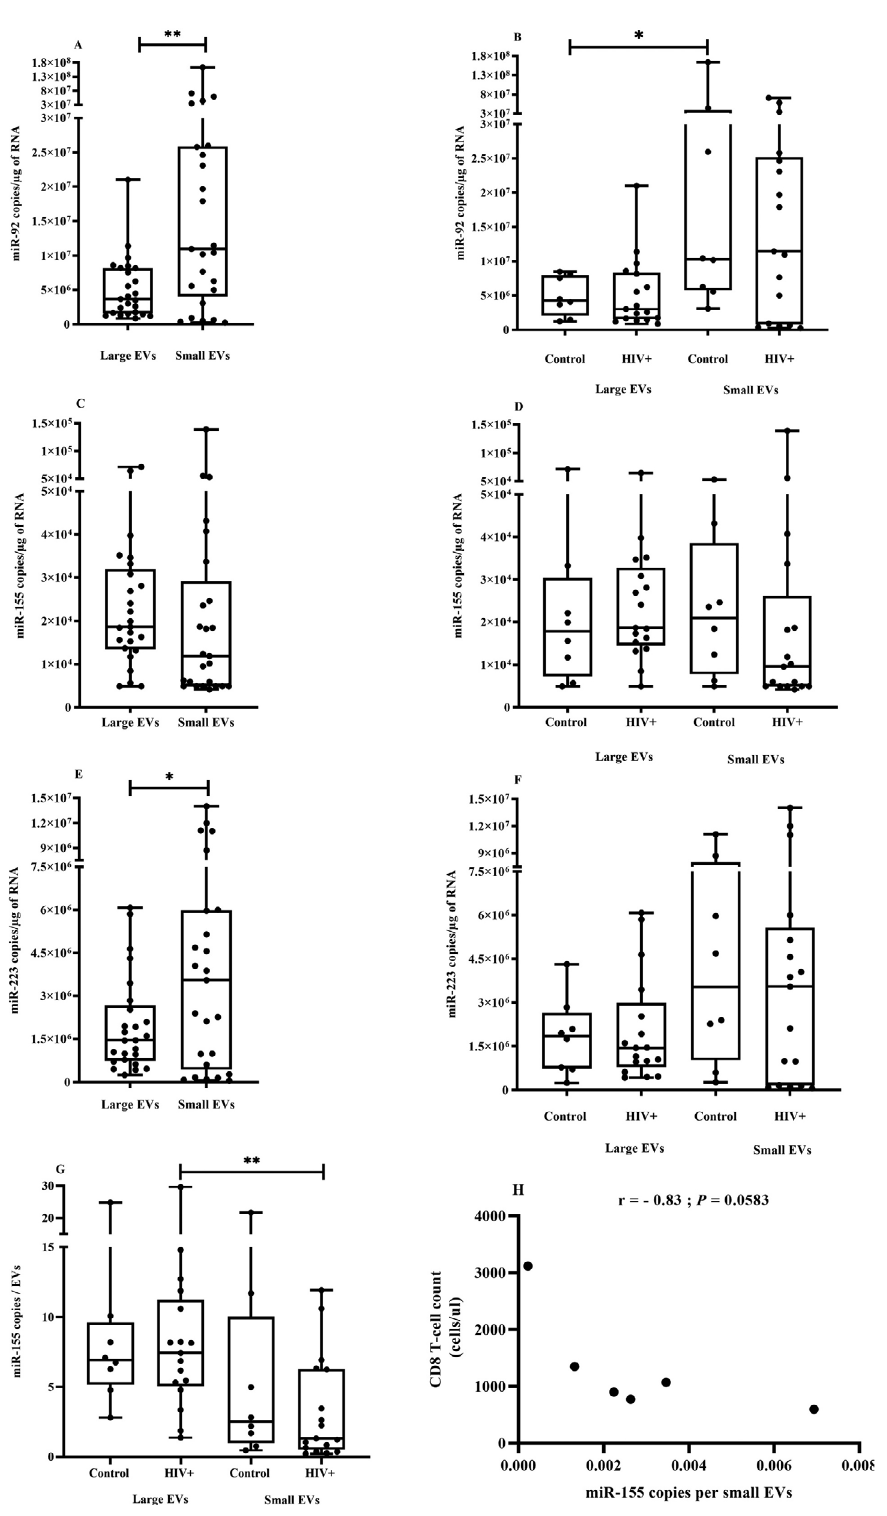
Figure 4. miRNA expression in plasma EVs in association with HIV. Plasma samples from uninfected participants (Control, n = 8) and HIV-infected patients (HIV+, n = 17) were pretreated with proteinase K before EV purification. Total RNA was extracted from small and large EVs using TRIzol LS as per the manufacturer’s instructions and treated with DNase I. miRNA-92 (Figure 4 A and B), miR-155 (Figure Figure 4C and D) and miR-223 (Figure 4E and F) were reverse transcribed and quantified as described in the Methods section. miRNA quantity was expressed as copy number per large and small vesicle in 1 milliliter of plasma as described in the Methods section, and (Figure 4G) presents miR-155 expression as copies per vesicle. Asterisks denote significant difference (* P ≤ 0.05; ** P ≤ 0.01) based on Wilcoxon matched-pairs signed- rank